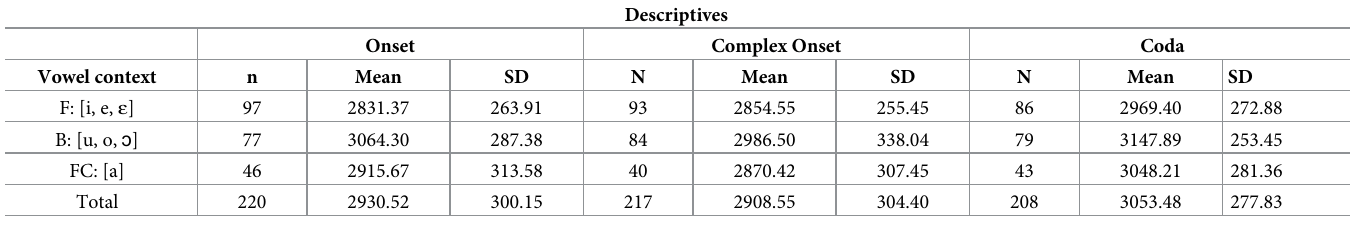
(in Hz) at the midpoint of the steady 3